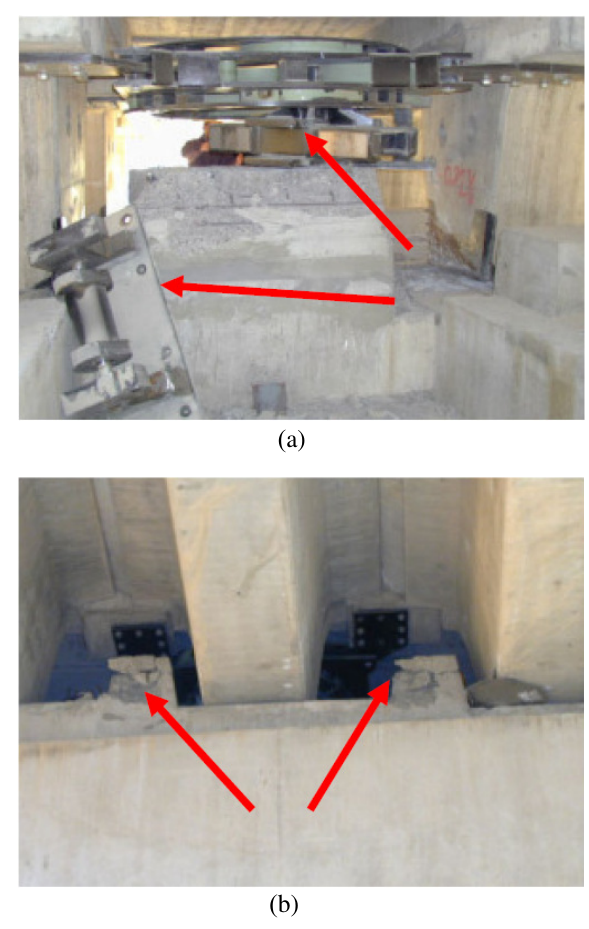
Fig. 3. Structural damage caused by the earthquake (a) dislodged Figure 3. Structural damage caused by the earthquake a) dislodged damper b) Movement in damper (b) Movement in transverse shear keys (from Park et al., Figure 2. General view of the Bolu Viaduct (modified from Url-1, 2010) transverse shear keys (from Park et al., 2004) Fig. 2. General view of the Bolu Viaduct (modified from www.bolu.net, 2010). In the first part of the research project the geodetic stations across the area surrounding the deformed viaducts were analyzed in terms of their viability for future use. Then, to establish the connections between control stations and object points and to analyse the damage caused by the earthquakes, all the points were re-measured using a space geodetic technique with Global Positioning System (GPS) receivers, total stations and precise levels. Hence, new coordinates were obtained for all the network stations and the new coordinates were compared with the previous coordinates of control stations to clarify the extent of their displacement. In this process, different transformation techniques were used. Since the geodetic network that existed in the area and the viaduct were seriously damaged by 3 individual cracks in the North Anatolian Fault the stretching and damage to the viaduct piers was investigated in two sections. The first part from Düzce in the Bolu direction to the point where the fault line crack runs under the viaduct and the second part from the crack in the Bolu to Duze direction. The viaduct region is divided into two parts with pier number 47 taken as the centre point. Therefore, analyses from two directions were examined to pier 48 from Düzce and to pier 46 from Bolu. 28 object points were measured on each of the piers to determine the extent of the displacement. The viaduct piers were transformed from points that are on viaducts